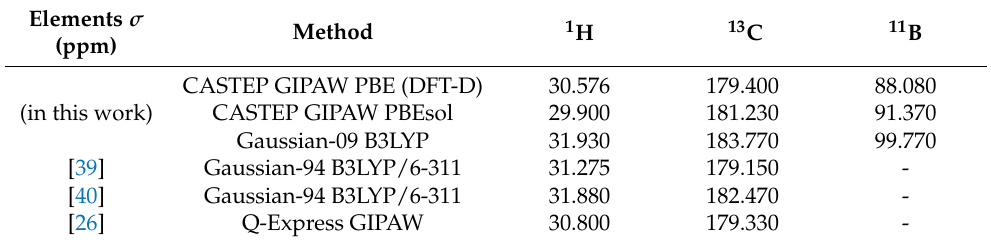
Table 6. Chemical shielding of 1 H, 13 C for Si ( CH 3 ) 4 and 11 B for BF 3 OEt 2 .